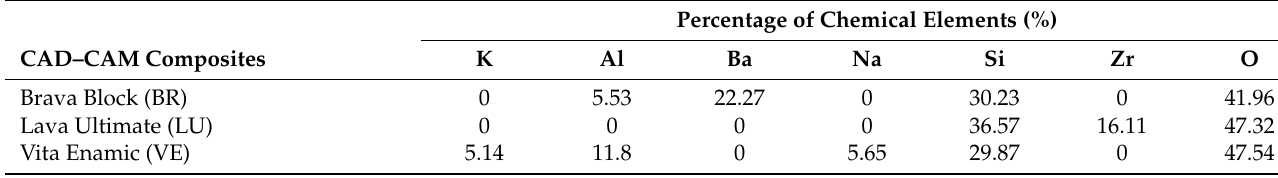
Table 6. EDS analysis of untreated